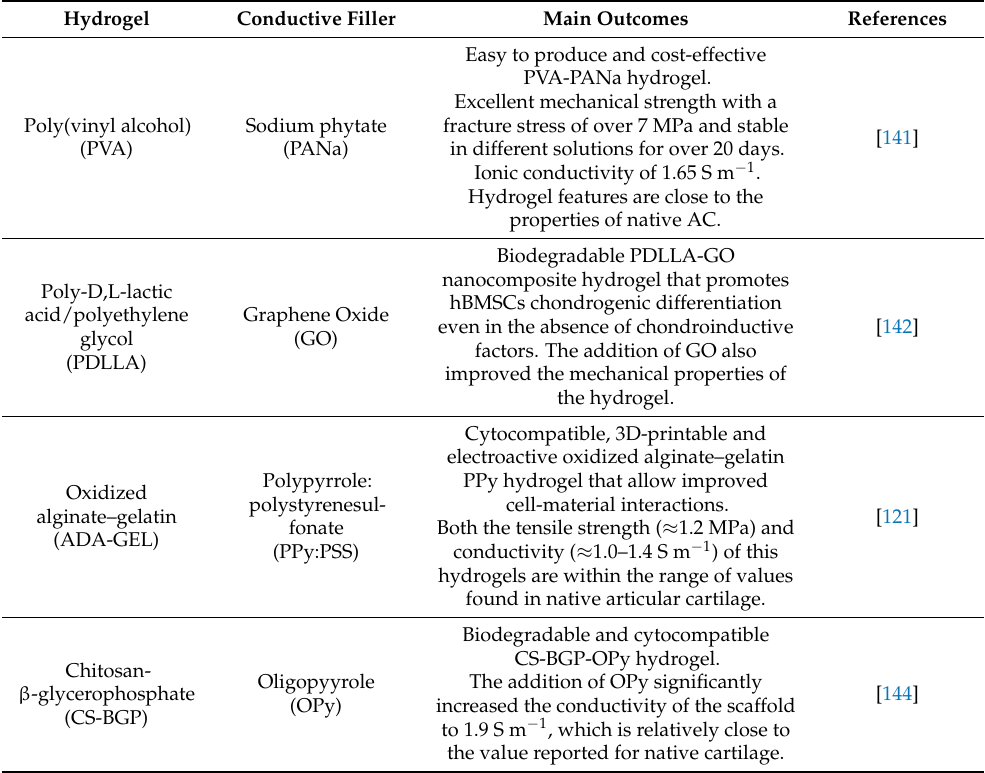
Table 5. Summary of research studies on electrically conductive hydrogels for AC tissue